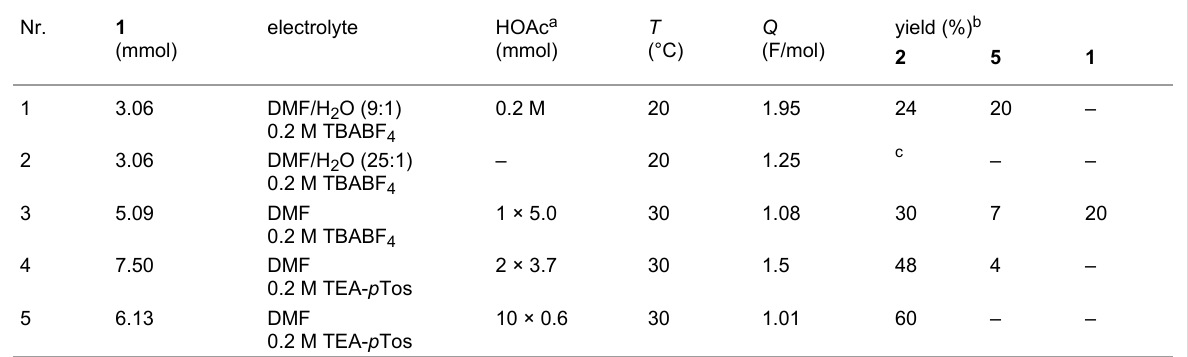
Table 1: Hydrodimerization of 1 in dependence on the electrolyte composition. Nr.